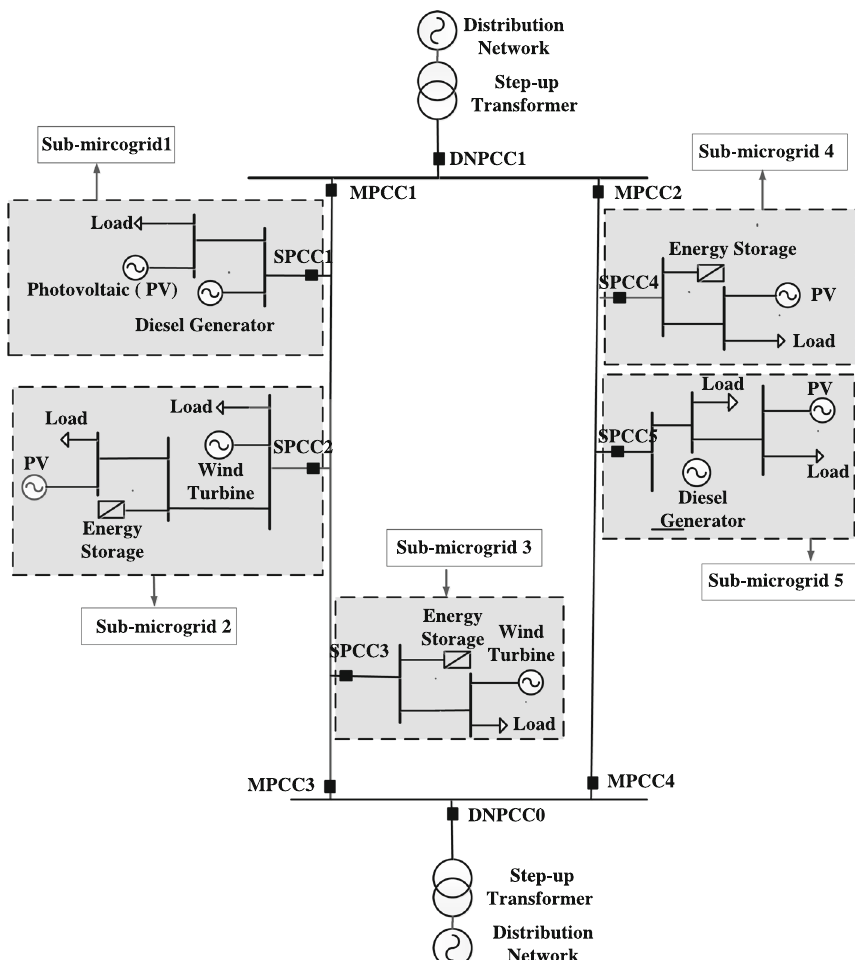
Fig. 1 Schematic diagram of the multi-microgrid